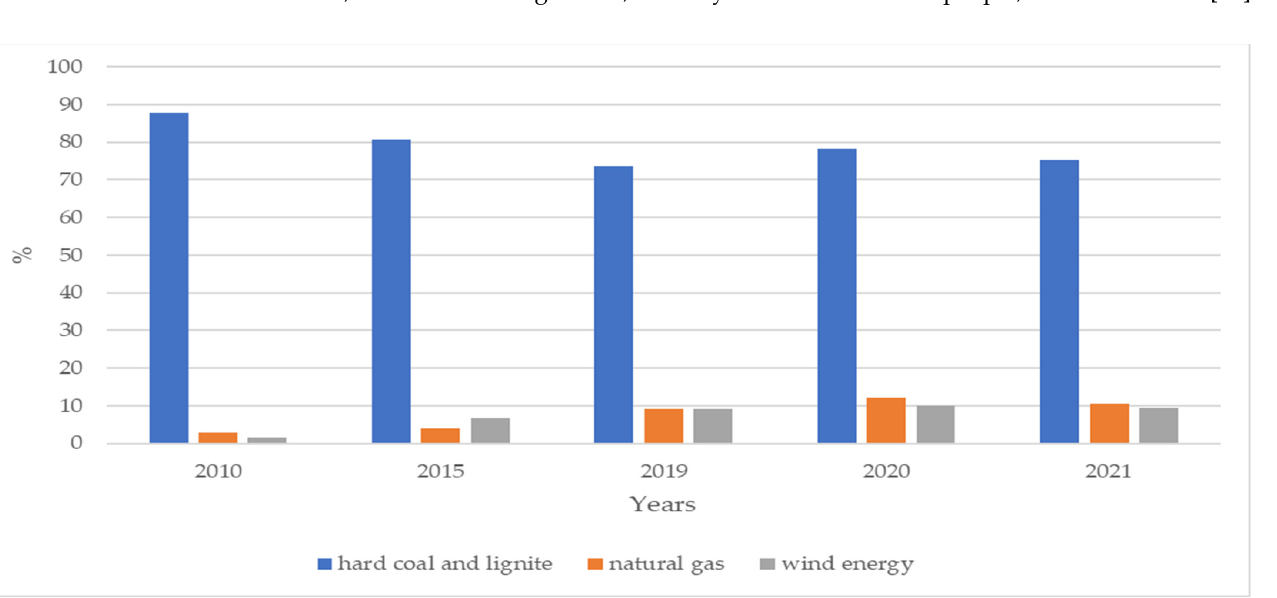
Figure 2. The share of electricity from renewable sources in the gross final consumption of energy in the electricity sector in Poland (%). Source: own elaborations based on [44].